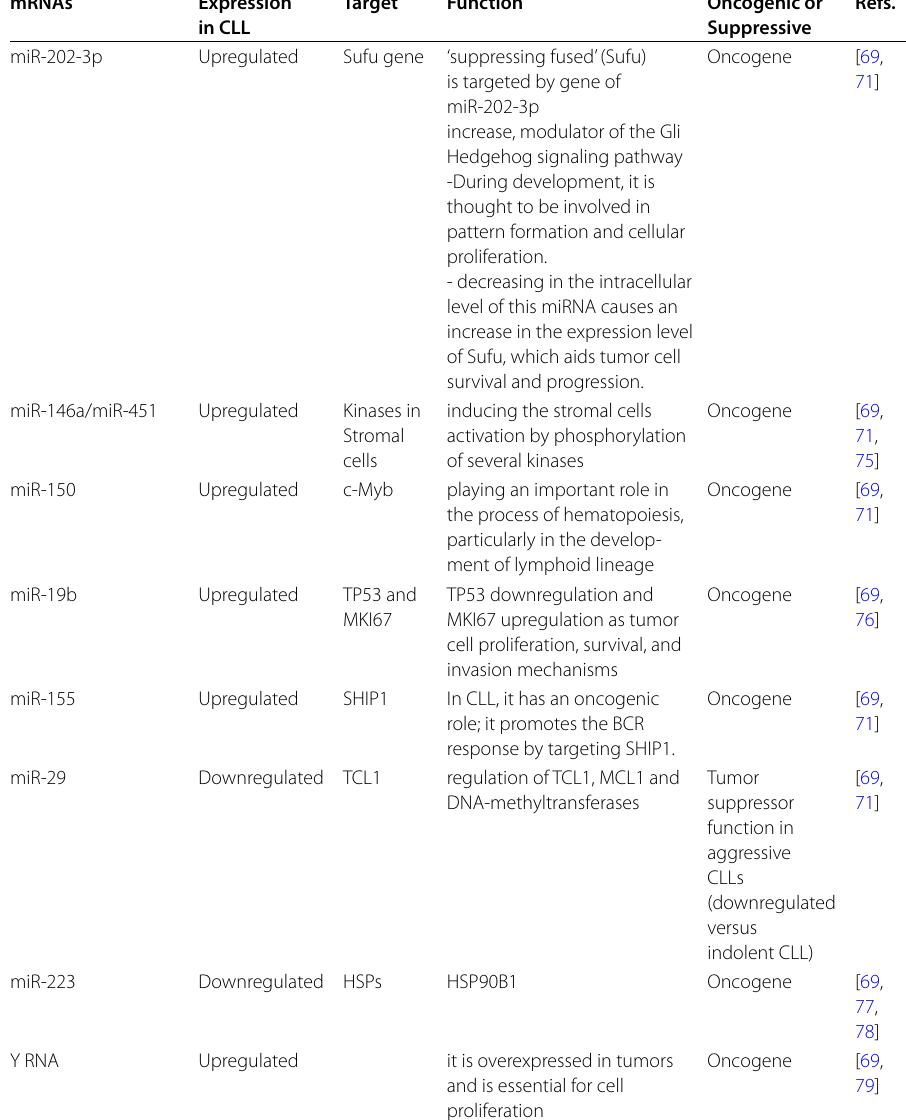
Table 1 Exosomal miRNAs in B-CLL